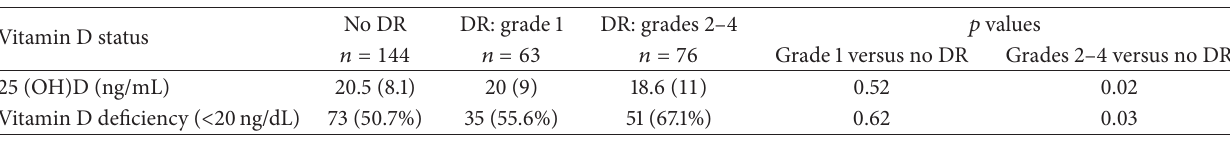
Values are 𝑛 (%). Table 4: Results of the analysis of serum 25(OH)D concentrations and frequency of vitamin D deficiency according to the severity of diabetic